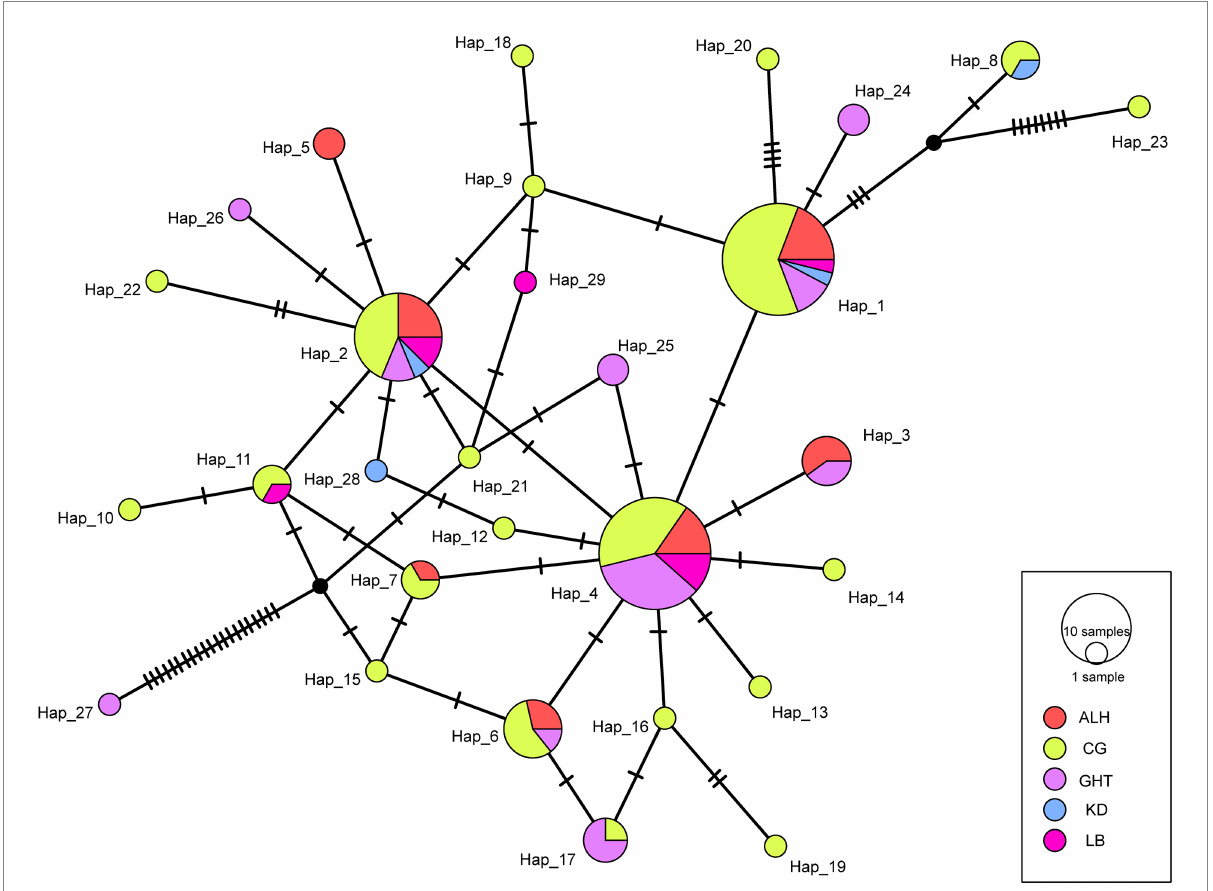
FIGURE 2 Statistical parsimony (TCS) network for the five local populations of Jankowski’s Bunting. The size of the circle is proportional to the frequency of each sampled haplotype. Every mutation is marked with a bar.